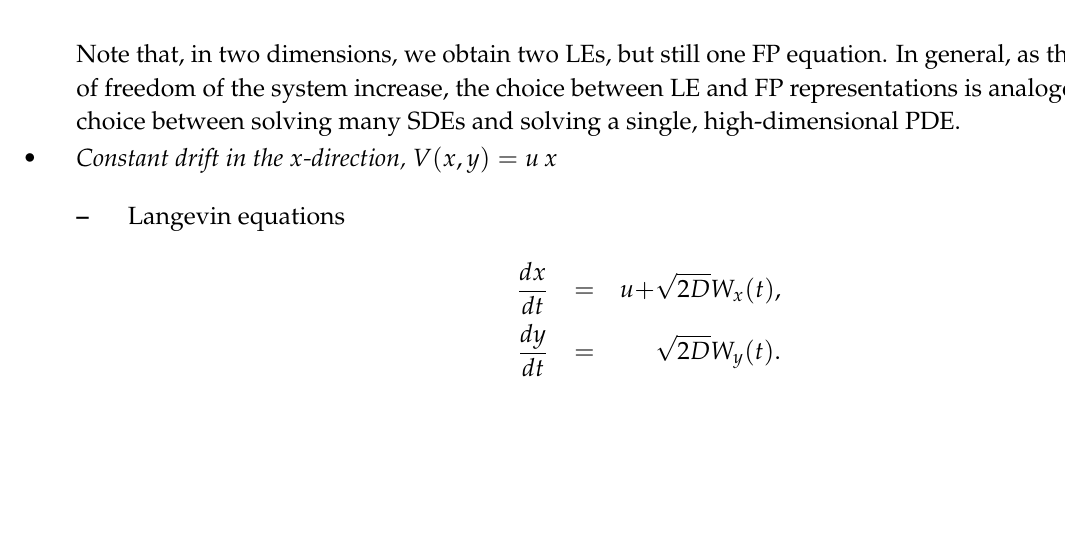
Figure 7. LE and FP solutions for two-dimensional Brownian motion without external field. For both representations, D = 10 − 2 µ m 2 /s and time is in seconds. For the LE representation, the total number of particles is 5 × 10 3